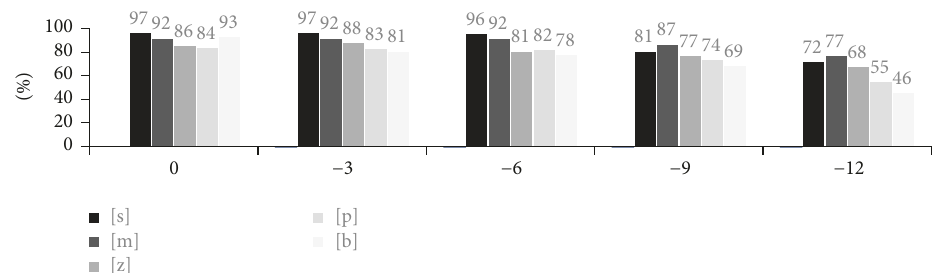
Figure 10: Correct recognition of consonants in first stressed syllable against white noise.